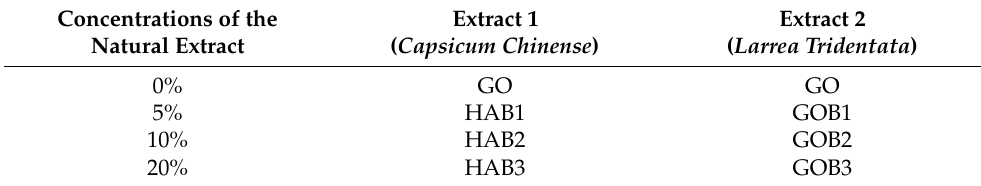
Table 1. Identification labels for each sample of reduced graphene oxide. Concentrations of the